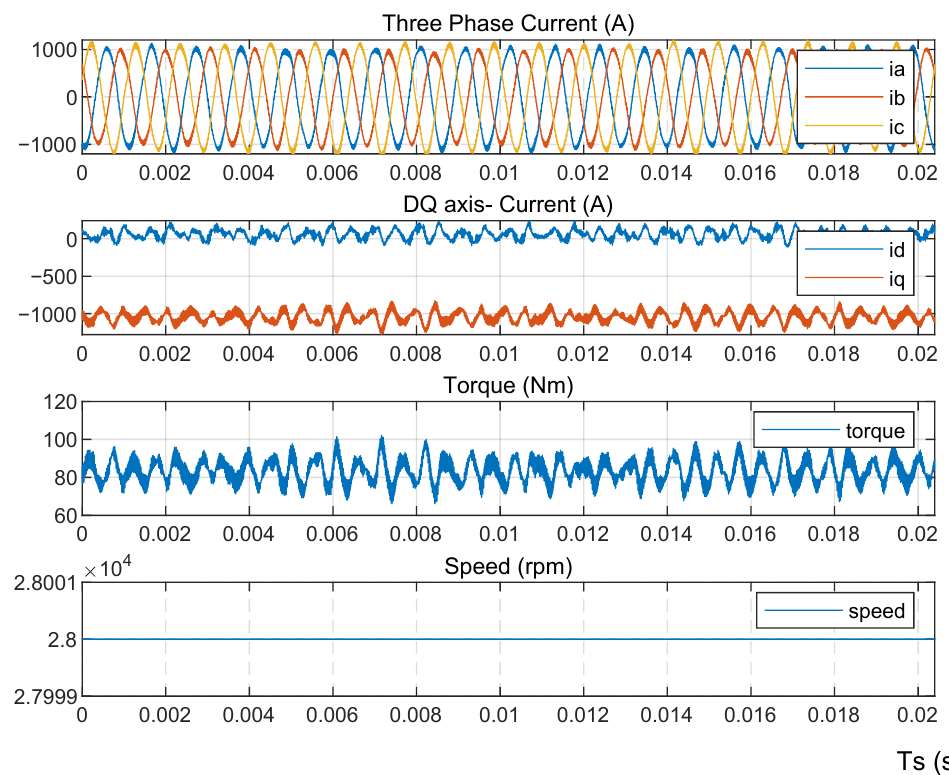
Figure 9. Experimental results of Model